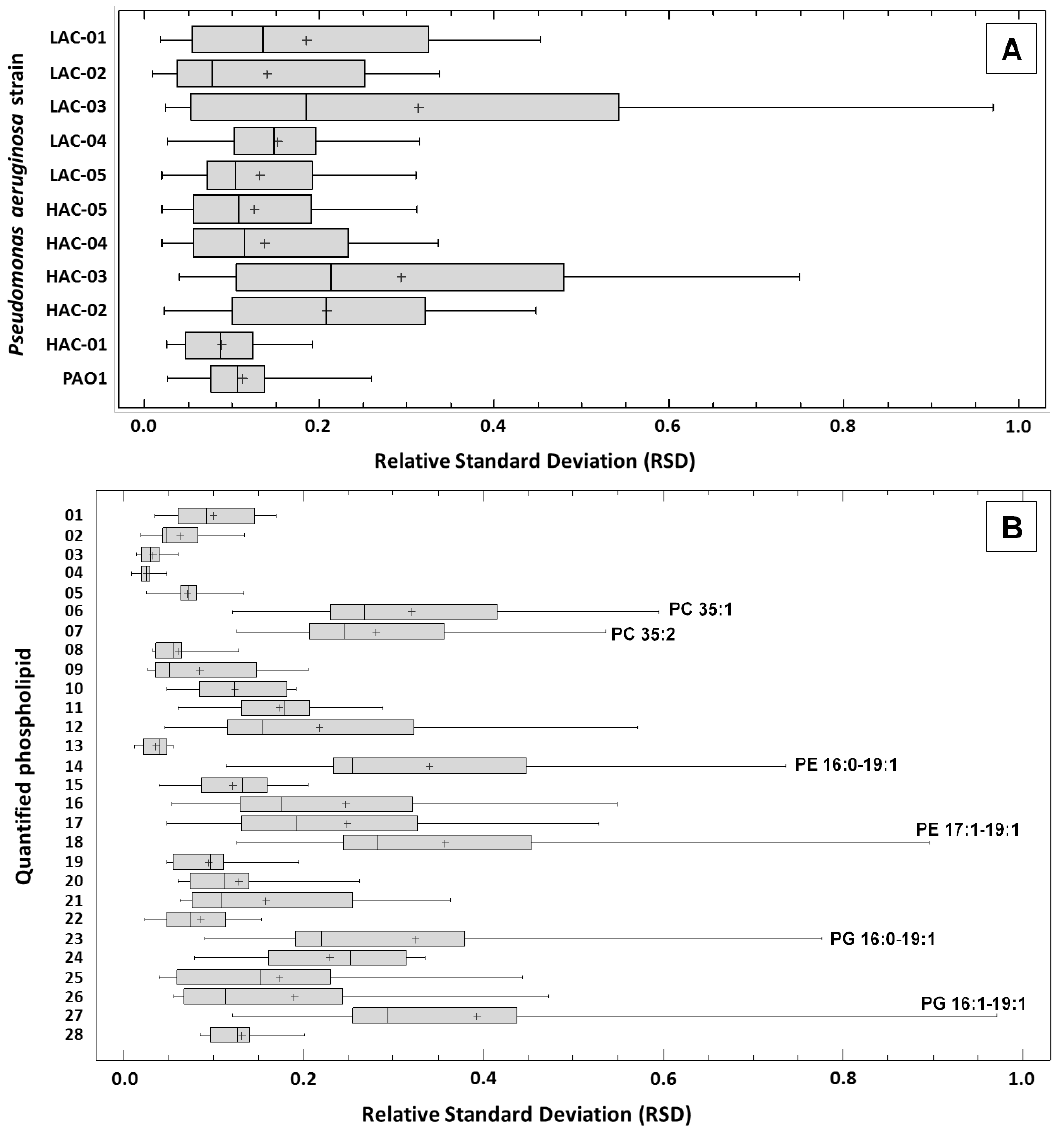
Figure 4. Repeatability of the phospholipids’ relative quantitation. Cells of each of the 11 Pseudomonas aeruginosa strains (10 clinical + PAO1) studied were harvested after 18 h of incubation on lysogeny broth (LB) agar. Each strain was grown in separate octuplates ( n = 8) and phospholipids (PLs) were extracted, leading to the quantitation of 28 PL species as detailed in the Materials and Methods section. The relative standard deviation (RSD) of the relative quantifications was used as the parameter for estimating experimental variability (Table S1). The analysis of the repeatability for each strain ( A ) took into account the 28 RSDs established for each PL quantified in this study, and the analysis of the repeatability for PL molecular species ( B ) took into account the 11 RSDs established for each strain. For each analysis, the RSDs’ distributions were presented in box-and-whisker plots obtained via Statgraphic Plus 5.1 software. The crosses (+) indicate the mean of the